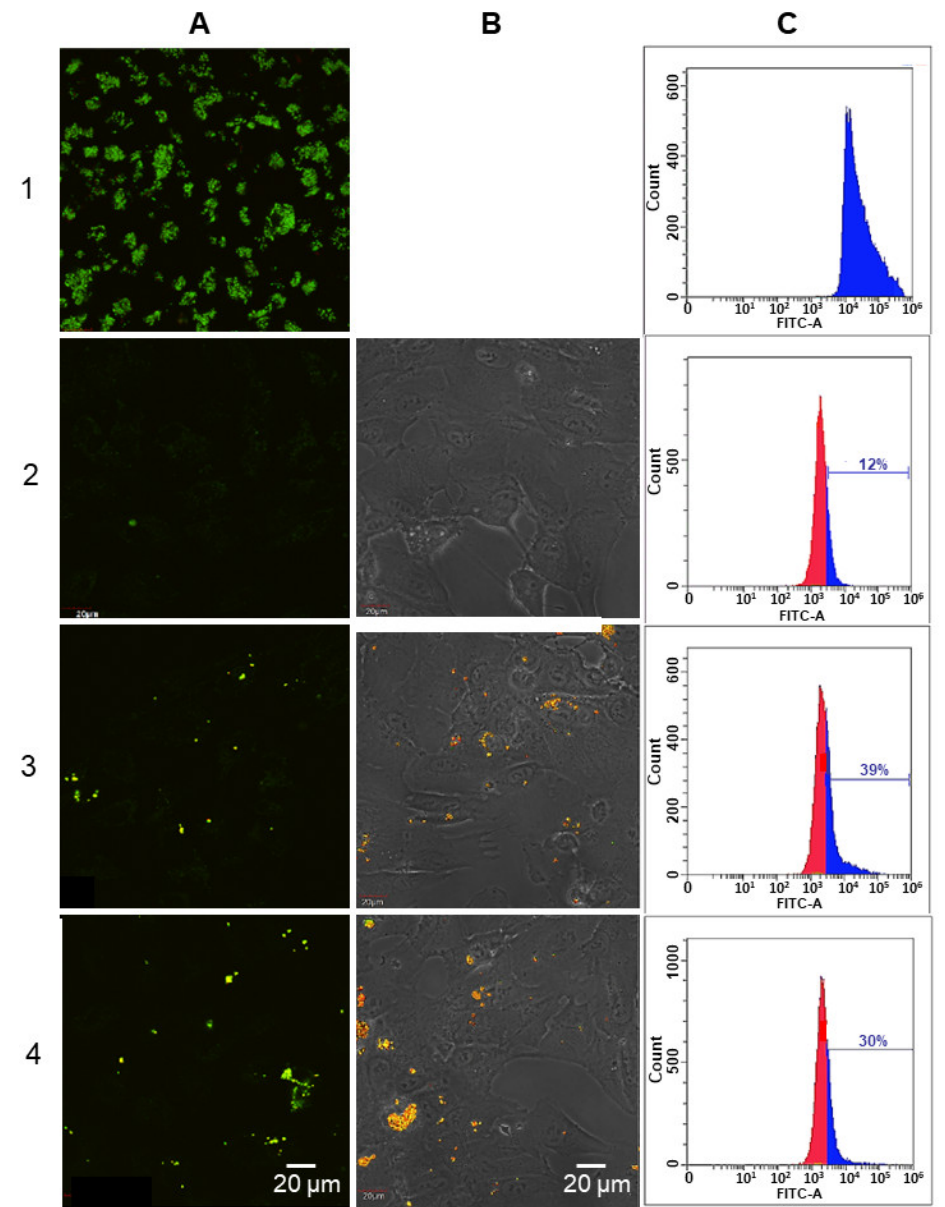
Figure 2. Laser scanning confocal microscopy: ( A ) fluorescence using the green channel AF 488 (Ex 490/Em 525); ( B ) phase contrast simultaneously with the image of the lipofuscin-fed RPE cell fluorescence, magnification: 600×. Flow cytofluorimetry ( C ) using detection channels such as FITC (Ex 493/Em 528) and Cy3 (Ex 550/Em 615): on the abscissa axis, fluorescence intensity is presented; on the ordinate axis, the values correspond to the number of RPE cells analyzed. Line 1—original lipofuscin granule (LG) suspension; 2—original RPE cell culture without LGs; 3—LG-fed RPE cells; 4—LG*-fed RPE cells.